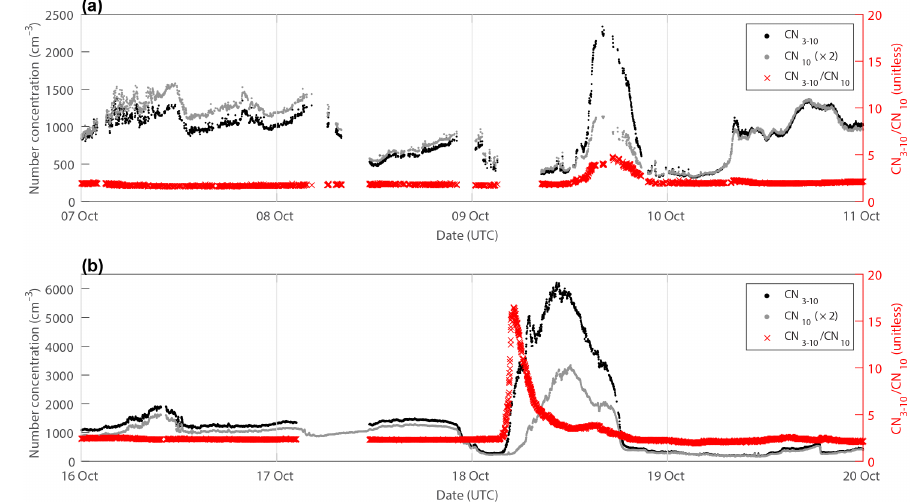
Figure 2. Four days of aerosol number concentrations in the two available size bins, 3–10nm (CN 3 − 10 ), and those larger than 10nm (CN 10 ), along with their ratio that helps to identify new particle formation and growth. (a) Four days representative of the data set show simultaneous variation in both size bins, and little variation in ratio data. (b) Similar to (a) , except that it includes the only growth event that was observed during the voyage, included to demonstrate what growth would look like with the available data, showing a delay in variations between the two size bins. Note the change in scale of the left y axis between the two